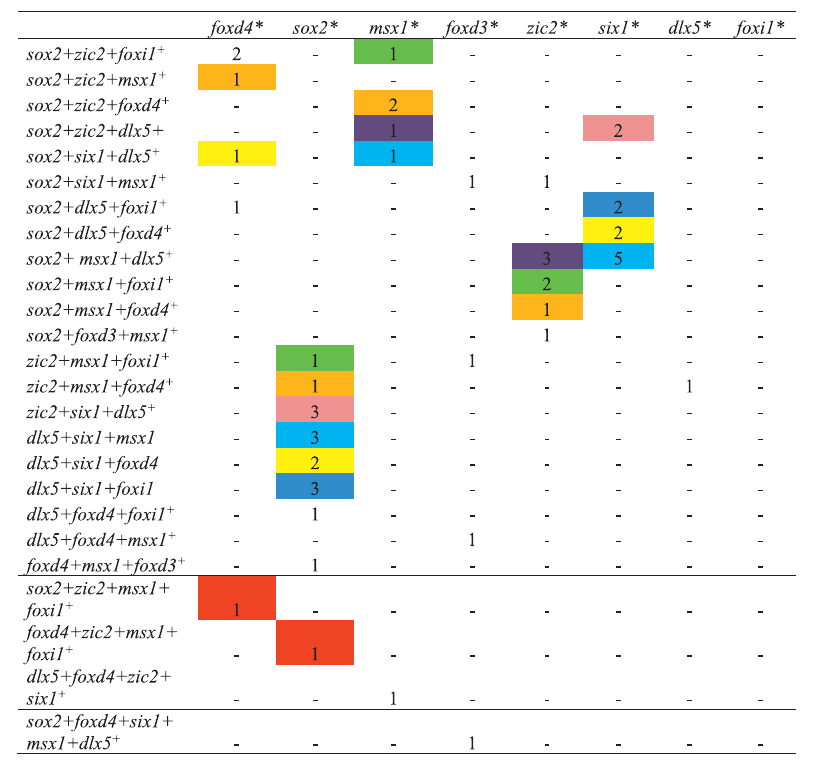
TABLE 7 | Number of single cells co-expressing four or more domain-enriched transcription factors at stage